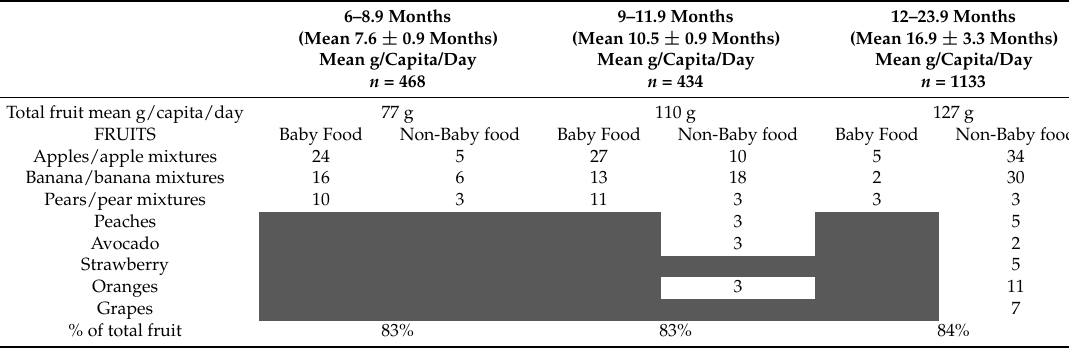
Table 2. Top Fruits Consumed by Age Range in Mean grams Per Capita: FITS 2016 *.